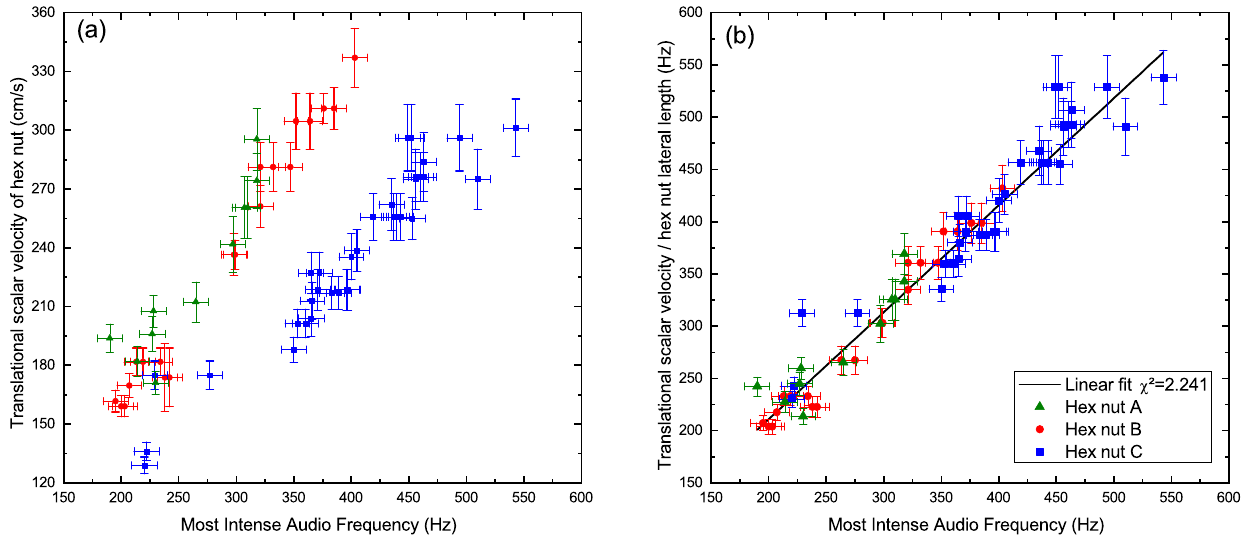
Fig. 5. Experimental results: (a) nut’s translational velocity as a function of the most intense frequency in the audio signal and (b) normalized nut translational velocity as a function of the most intense frequency of the audio signal, whose slope is (1 . 02 ± 0 . 02) and the intercept is (6 ± 5) Hz. χ 2 is the reduced chi-squared statistic that represents goodness of our fit.